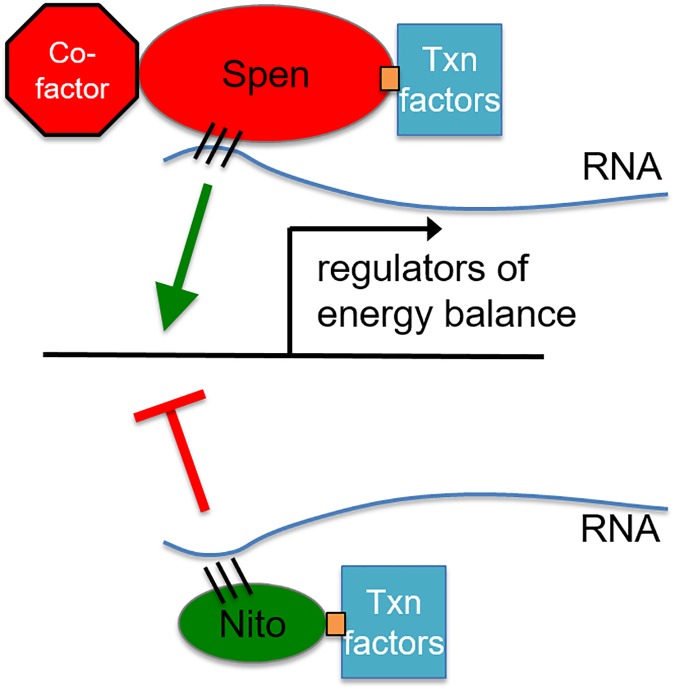
Model: Spen family members counter-regulate metabolism.Our model predicts that Spen and Nito bind the same or similar RNAs via the RRMs as well as transcription factors via the SPOC domain. Spen acts to activate enzymes key for the mobilization of energy stored as fat while Nito antagonizes this function. Spen may achieve this activation by binding additional factors in the uncharacterized region between the RRMs and SPOC domain not found in Nito.